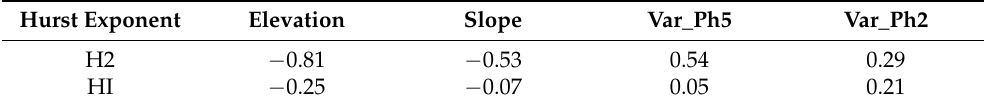
Table 2. Correlations between H2 and HI with elevation, slope, and variances from phases 5 and 2. Hurst Exponent Elevation Slope Var_Ph5 H2